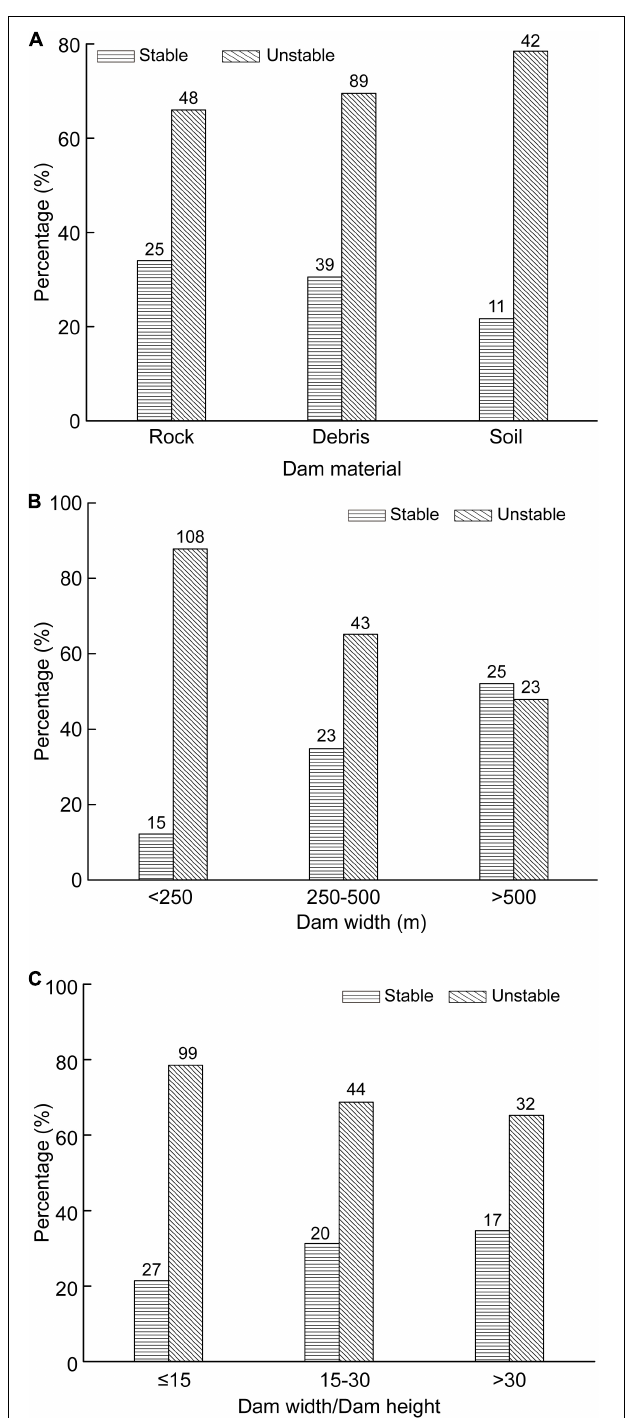
Dam volume The global dam stability increases with increasing landslide dam volume ( Figure 6 ). The proportions of failed landslide